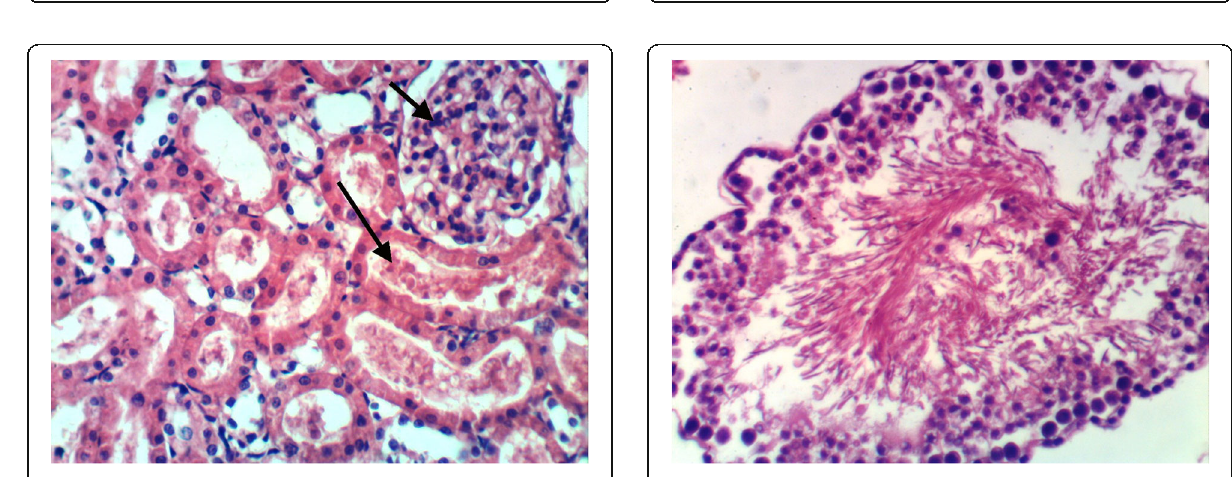
Fig. 4 Photomicrograph of rat ’ s kidney fed the balanced diet and orally administered pot.bromateshowing hypercellularity of glomerular tuft (H&E ×400)